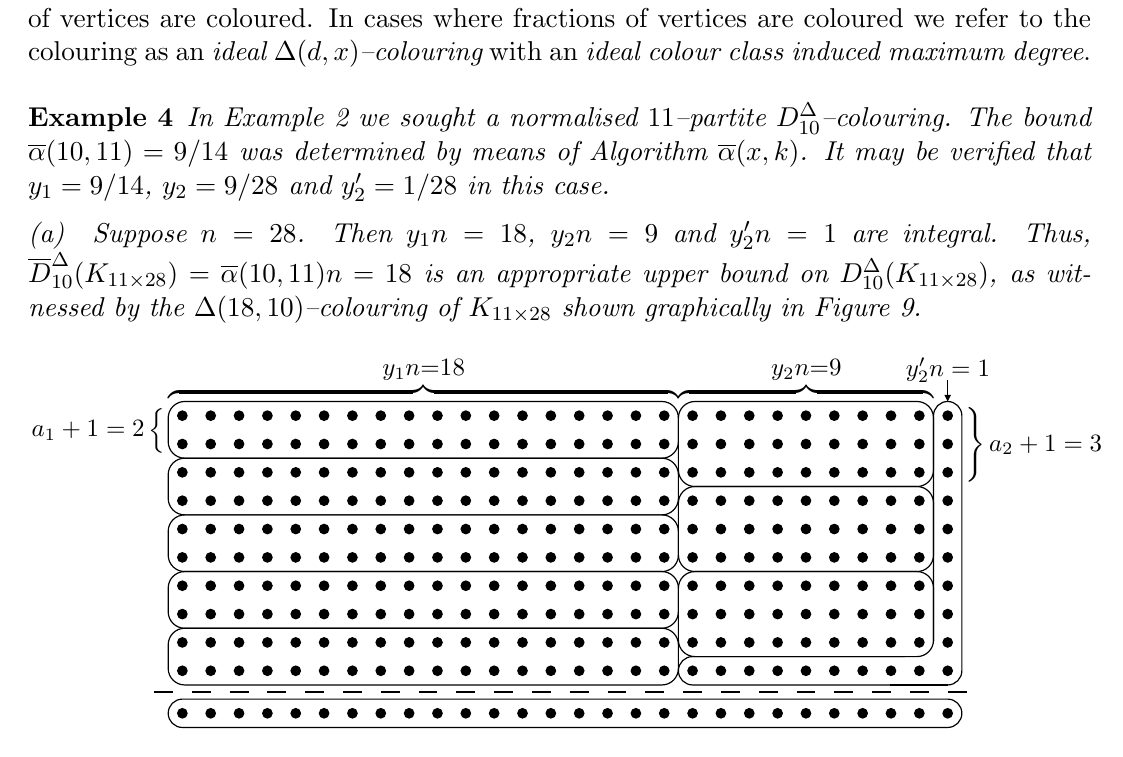
Figure 9: Graphical representation of a ∆(18 , 10) –colouring of K